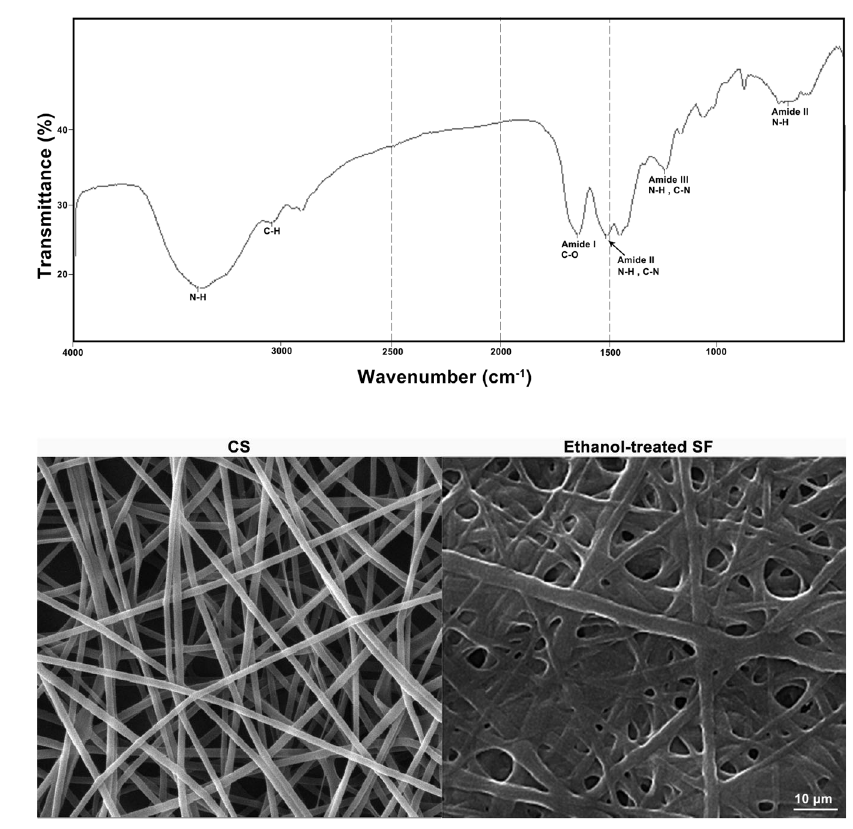
Fig. 1 FTIR spectra of silk fi broin. FTIR spectra of silk fi broin.The bands at 1648 cm − 1 , 1513 cm − 1 , and 1241 cm − 1 represent amide I (C = O stretching), amide II (secondary N-H bending) and amid III (C – N and N – H functionalities) groups, respectively